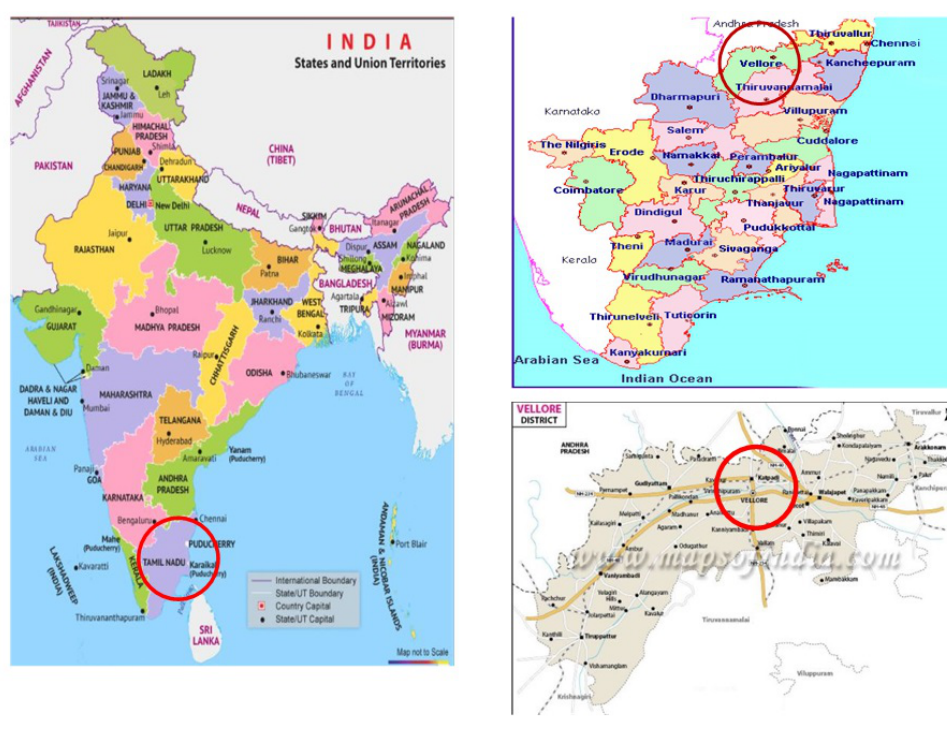
Fig. 1. Geographical location of study